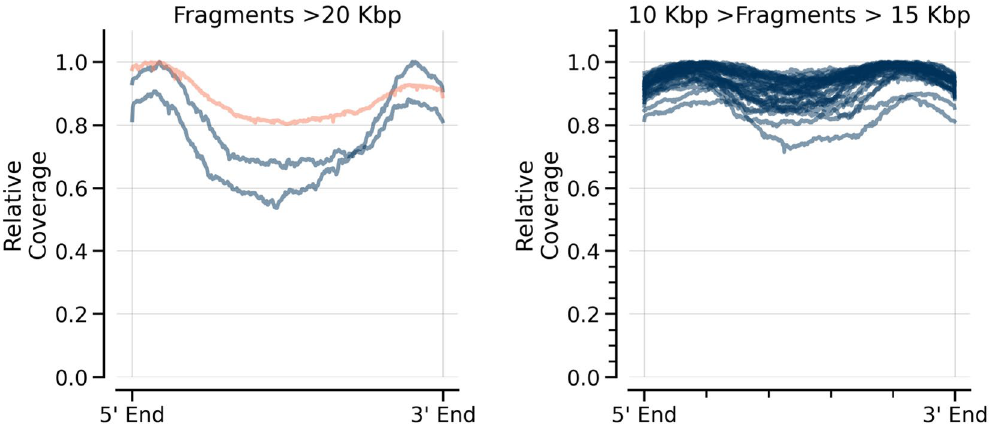
Figure 2. Coverage of long fragments. The relative coverage of individual DNA fragments is shown for E. coli (blue) and lambda (orange). Each line represents an individual PvuII fragment from either E. coli (blue) or lambda (orange). With PvuII, there were no lambda fragments with a size of 10–15 kb while the 30 such E. coli fragments are each shown individually in blue. Coverage across the length of each fragment is normalized to the maximum for the given DNA and then plotted versus the normalized length. The dip in coverage in the middle of the fragments is most extreme for long E. coli fragments.